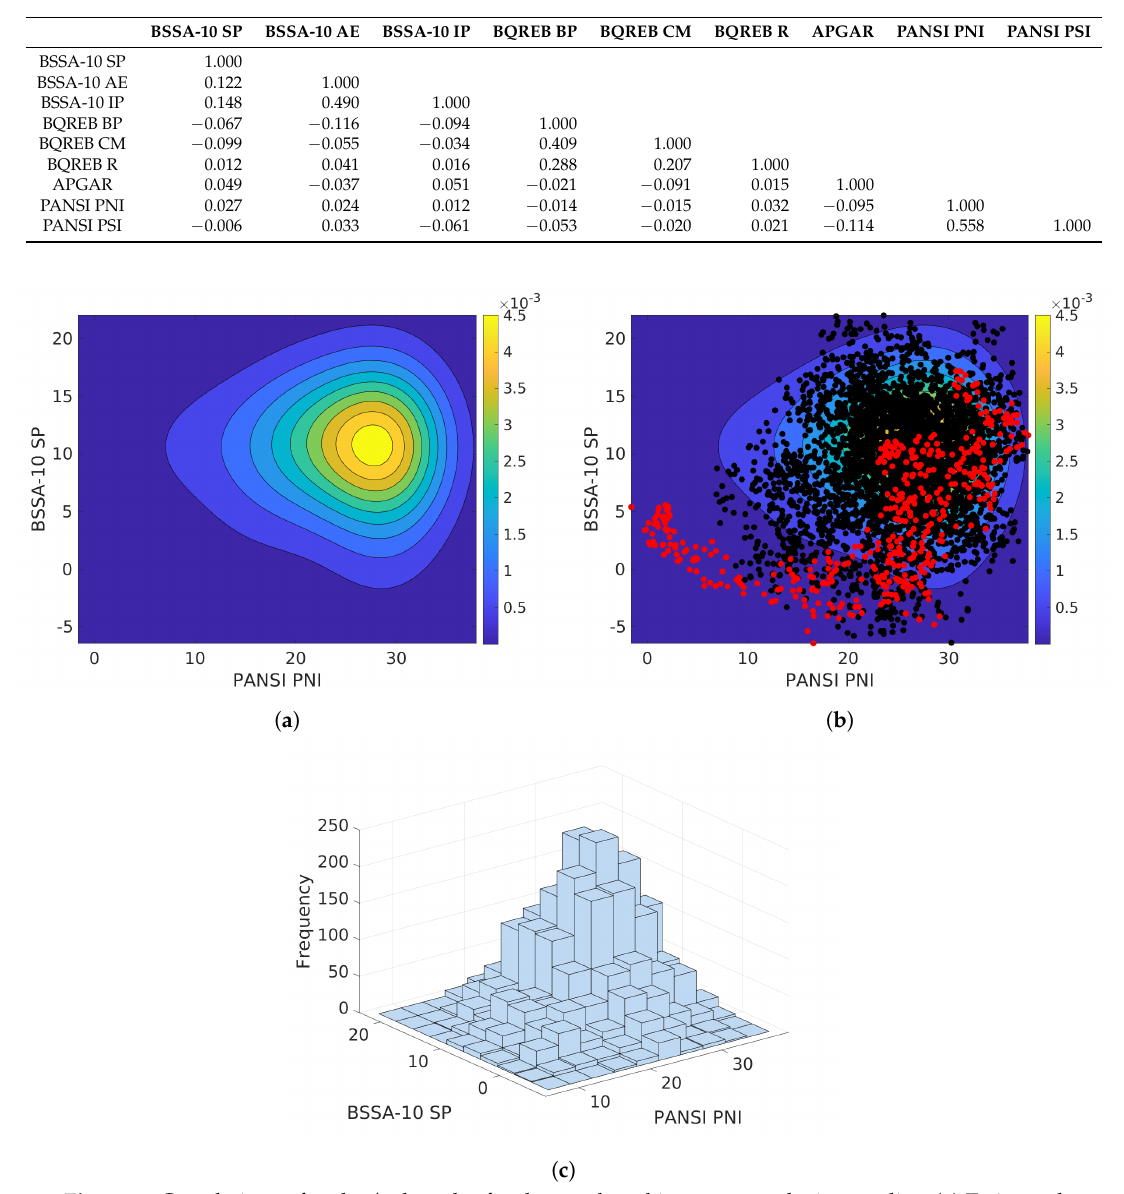
Figure 4. Correlations of scales/sub-scales for the employed instruments during studies. ( a ) Estimated Joint PDF. ( b ) Markov Chain. ( c ) Samples from the Joint